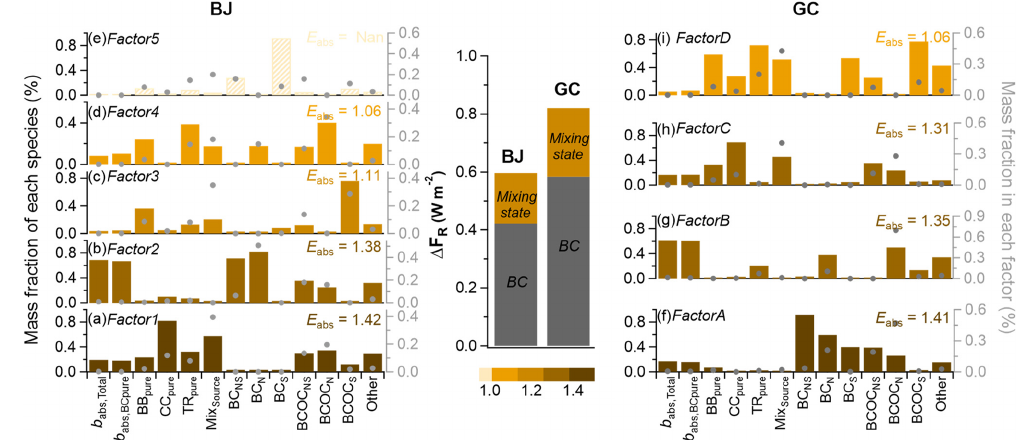
Figure 5. Factor profiles and their contributions to each factor identified by the positive matrix factorization model in Beijing and Gucheng. b abs , total and b abs , BCpure represent light absorption (Mm − 1 ) of coated BC particles and pure BC, respectively. BC types, e.g., BB pure , in counted